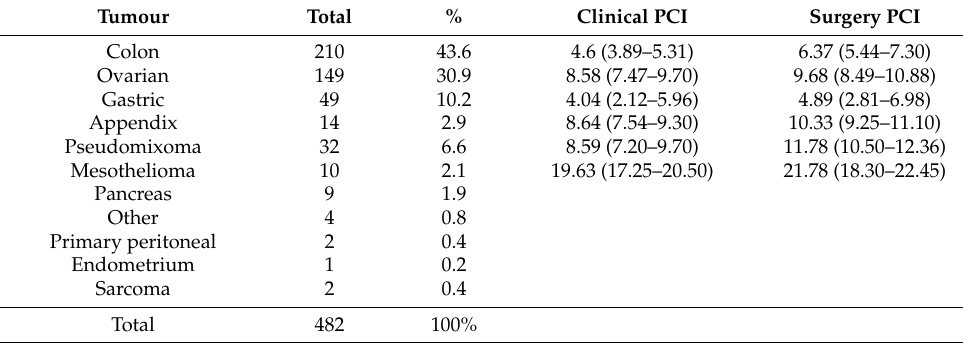
Table 2. Types of Table 2. Types of tumours.